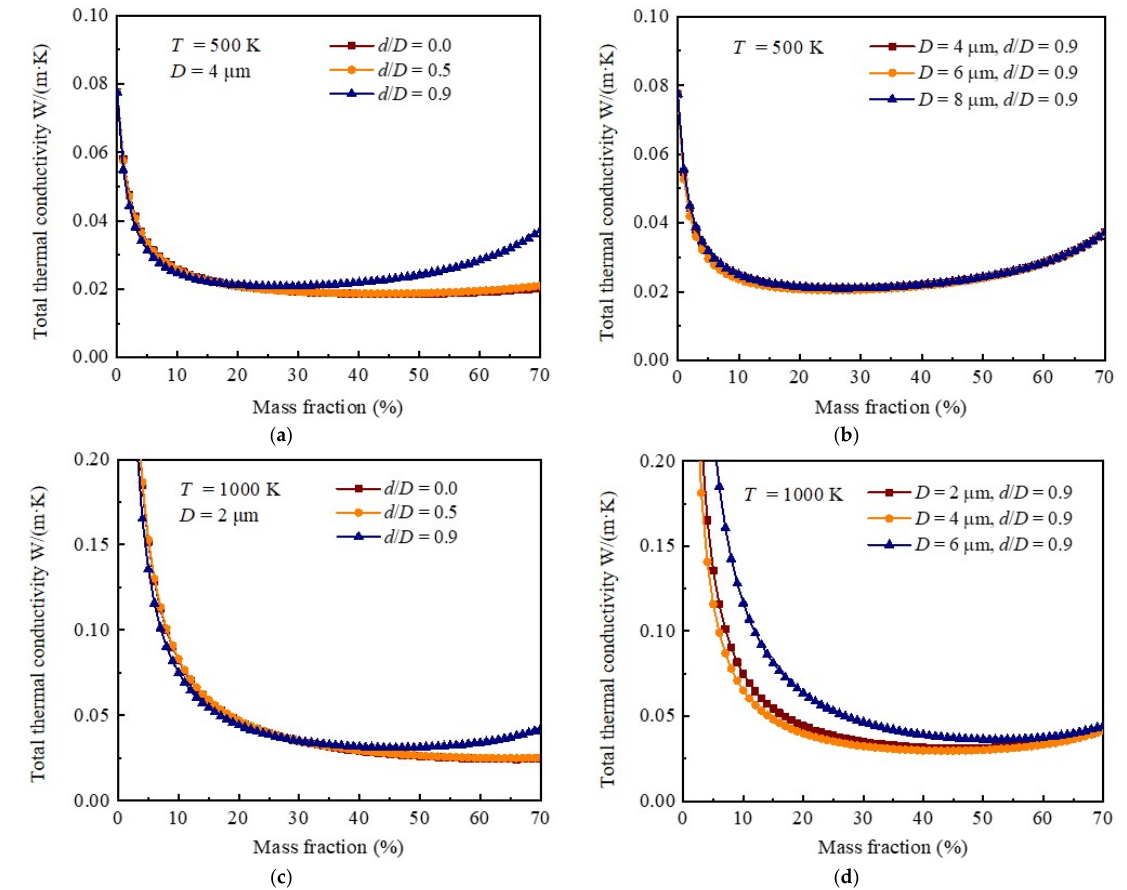
Figure 6. Influence of mass fraction of doped opacifiers on the total thermal conductivity of silica aerogel composite. ( a ) Total thermal conductivity of hollow opacifier-doped aerogel at 500 K as a function of mass fraction, where the outer diameter is 4.0 µm, and d / D is 0, 0.5, and 0.9, respectively. ( b ) Total thermal conductivity of hollow opacifier-doped aerogel at 500 K as a function of mass fraction, where d / D = 0.9 and the outer diameters are 4.0, 6.0, and 8.0 µm, respectively. ( c ) Total thermal conductivity of hollow opacifier-doped aerogel at 1000 K as a function of mass fraction, where the outer diameter is 2.0 µm, and d / D is 0, 0.5, and 0.9, respectively. ( d ) Total thermal conductivity of hollow opacifier-doped aerogel at 1000 K as a function of mass fraction, where d / D = 0.9 and the outer diameters are 4.0, 6.0, and 8.0 µm, respectively.